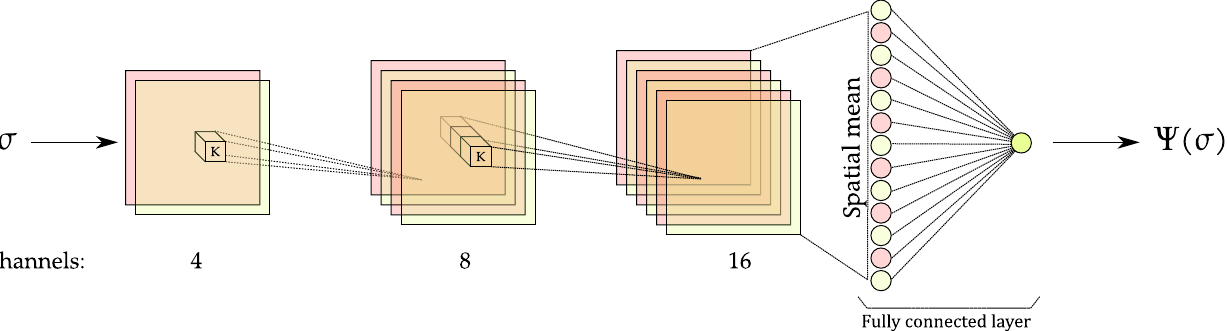
FIG. 7. Standard translationally invariant neural network used in the paper. The spin configuration σ ¼ v 0 l; ð 4 ; L x ; L y ; L z Þ tensor, and it then undergoes a sequence of convolutions in accordance with Eq. (A2). After the last convolution, the tensor ð C; L x ; L y ; L z Þ is spatially averaged (in this example, C ¼ 16 ) and is fed to the fully connected layer, given by Eq. (A1). The resulting number is then interpreted either as log j Ψ ð σ Þj or arg Ψ ð σ Þ